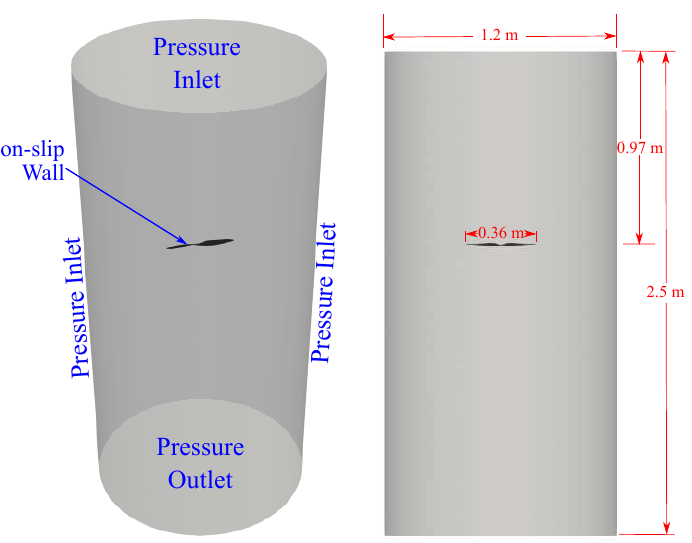
Figure 4. Stationary and rotating reference